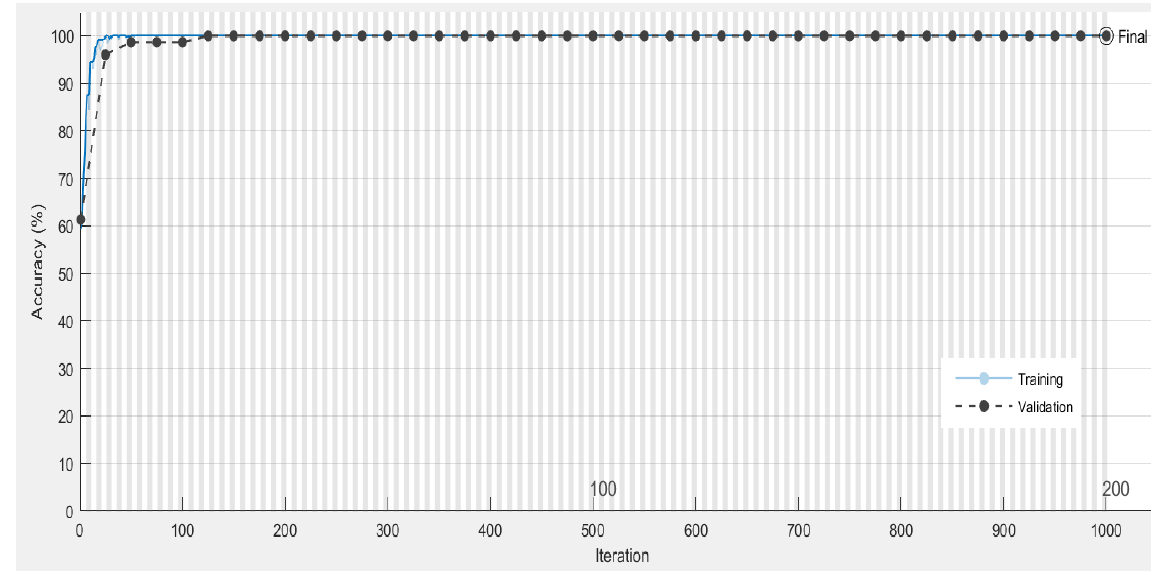
Figure 12. Plots of accuracy versus number of iterations obtained using GRU classifier with hold-out CV for automated classification of BFMAC vs. DMAC tasks.